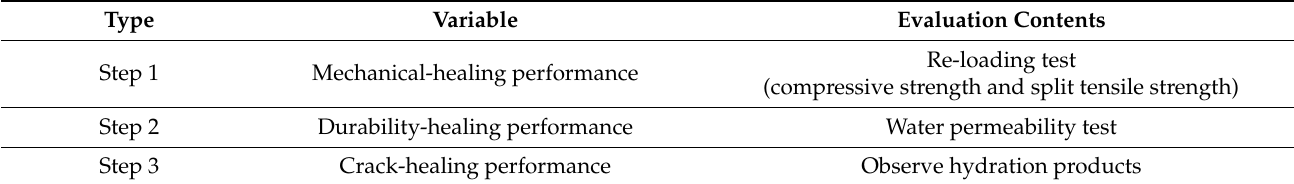
Table 4. Experimental parameters and evaluation contents.